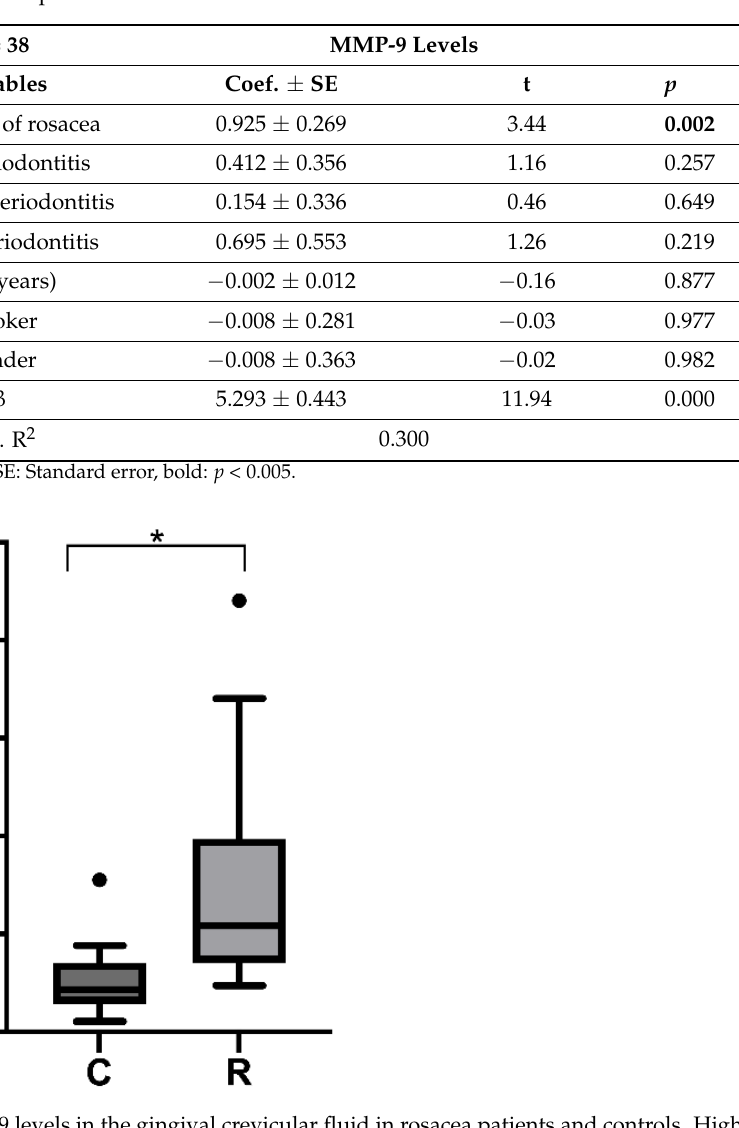
Table 2. Results of de multiple regression models for MMP-9 levels in gingival crevicular fluid in rosacea and control patients.